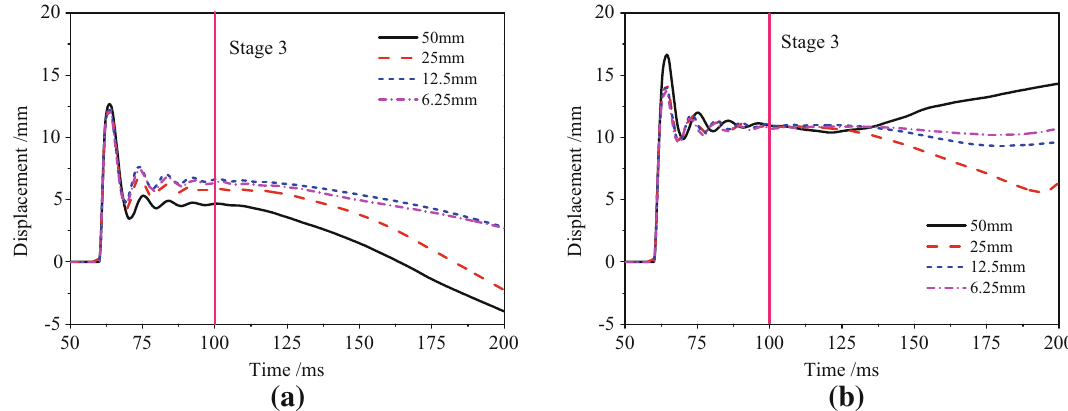
Fig. 7 Mid-span transverse displacement time histories of different mesh sizes a KCC, b CSC.